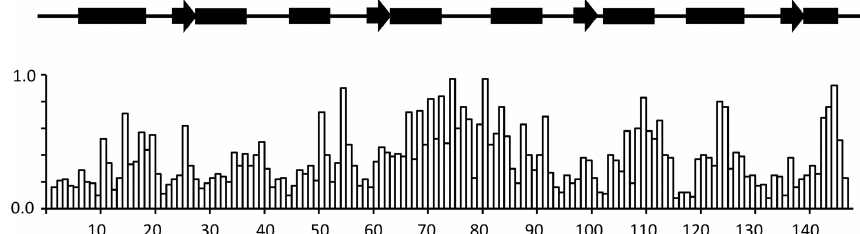
Figure 3. Chemical shift changes for backbone CaM resonances upon binding idoxifene. Normalized, weighted average chemical shift changes are plotted against the primary sequence of CaM. Secondary structure elements are indicated above the histogram as solid boxes for α helices, solid arrows for β strands, and thin lines for unstructured regions. The flexible tether (E67–V85) experiences the largest chemical shift changes upon complex